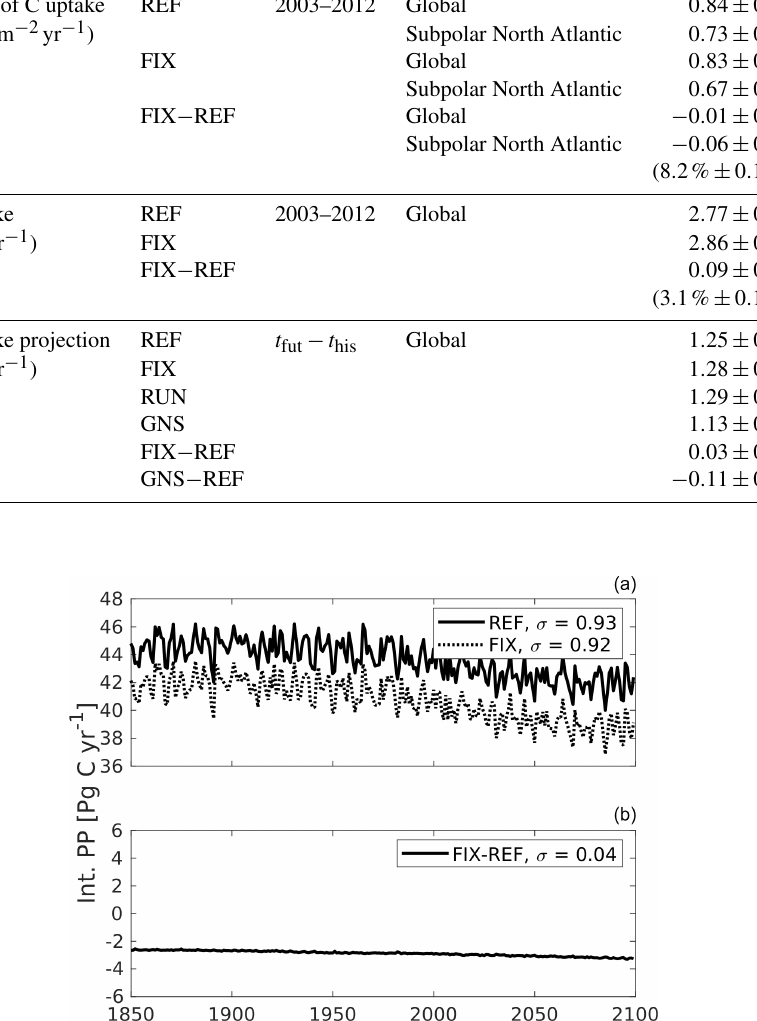
Figure B1. Global integrated primary production (PP) time series from single experiments (a) versus the difference between two experiments (b) . The PP variability in REF and FIX closely follow each other because the simulations feature the exact same physical variability. As a result, the interannual variability largely cancels out in the computation of FIX − REF differences, and the FIX − REF difference time series exhibits a standard deviation that is an order of magnitude smaller than the standard deviations of REF and